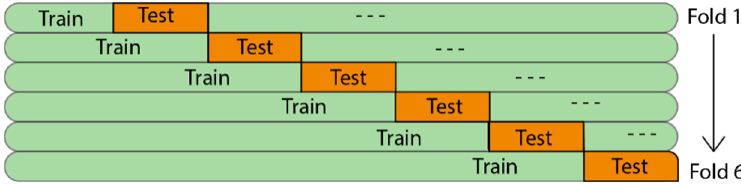
Figure 5. CV with length of first train-fold = length of first test-fold (=